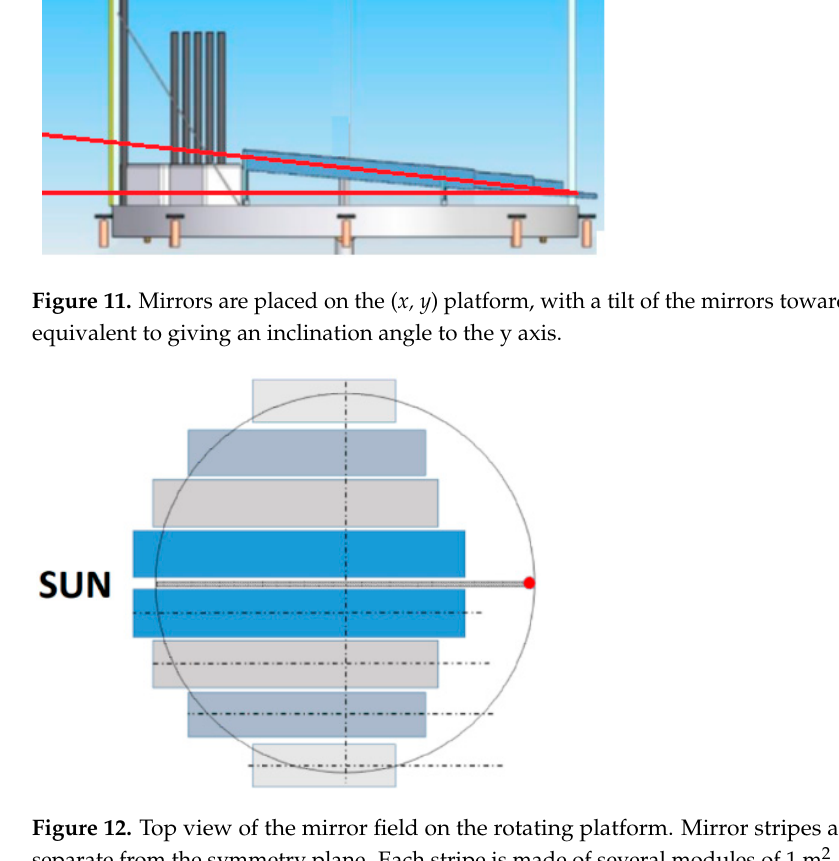
Figure 12. Top view of the mirror field on the rotating platform. Mirror stripes are shorter as they separate from the symmetry plane. Each stripe is made of several modules of 1 m 2 , which are bent as described above.